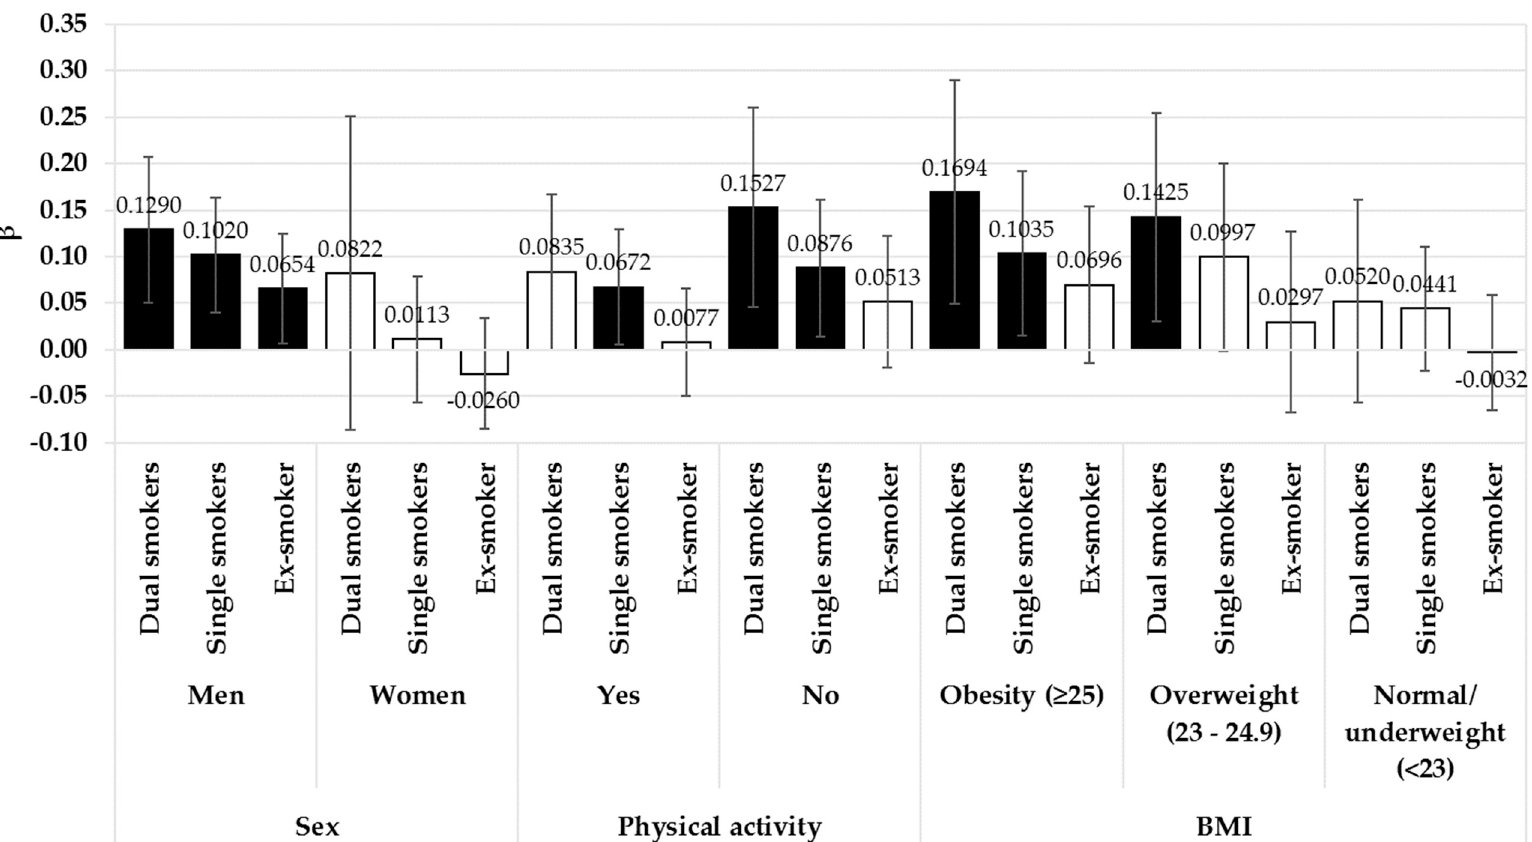
Figure 1. The results of subgroup analysis with multiple regression to investigate the association between smoking behavior and HbA1c according to sex, physical activity, and BMI. Black bars are statistically significant results ( p < 0.05). Non-smokers were the reference group. Analyses were adjusted for the following covariates: age, sex, occupation, household income, educational level, BMI, physical activity, pack-years of cigarette smoking, alcoholic behavior, family history of diabetes mellitus, year, and caloric intake.